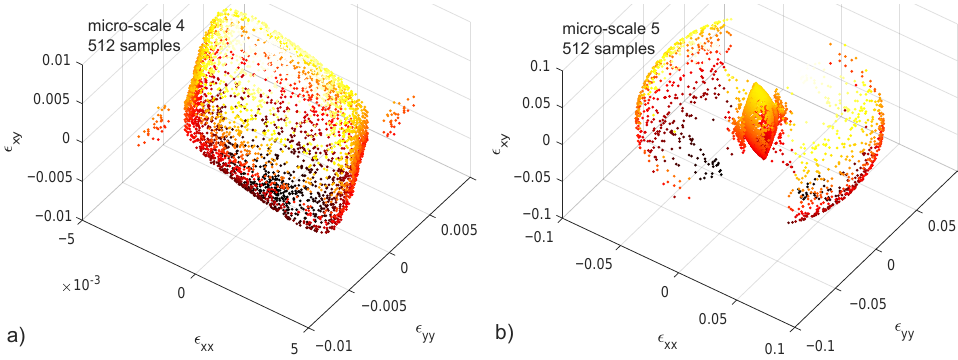
Figure 9. Failure points in the xx – yy – xy strain space. 512 samples in each case. Colorbar represents the value of (cid:101) xy . Crack stiffness G = 1 supplementary